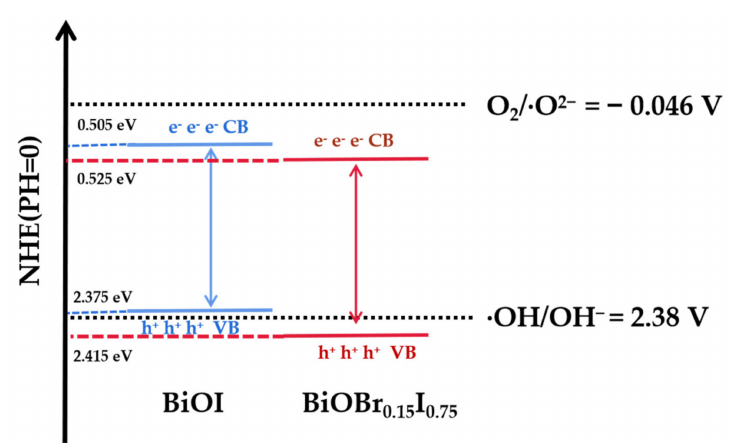
Figure 11. Schematic diagram of the BiOI and BiOBr 0.15 I 0.85 reaction mechanism for photocatalytic degradation of RhB.